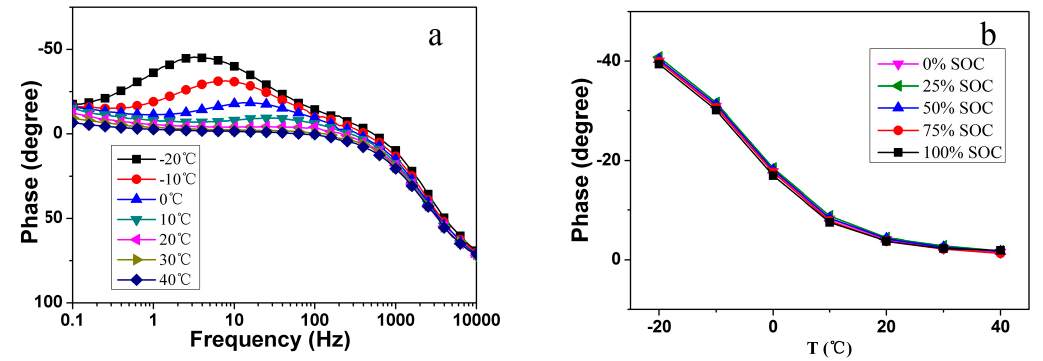
Figure 4. Relationship between impedance phase shift and temperature. ( a ) Phase shift at different frequencies and 50% SoC; and ( b ) the phase shift at various SoC and 10 Hz.